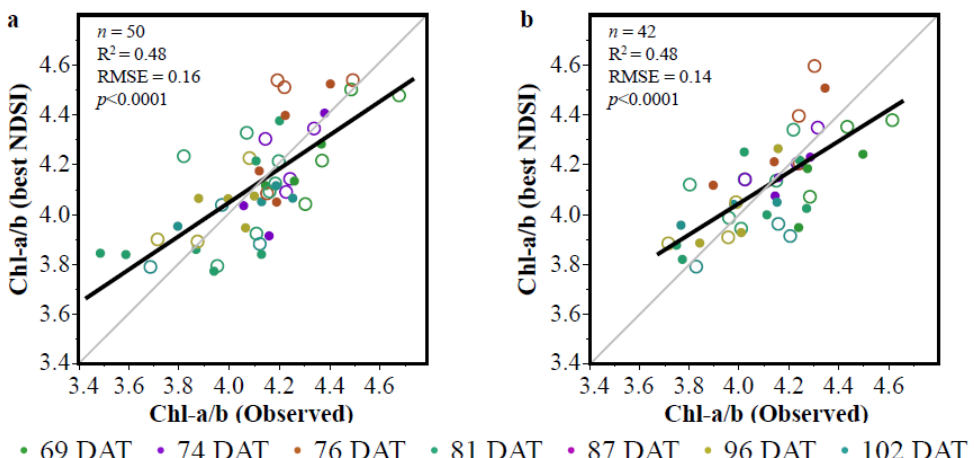
Figure 4. Quality of Chl-a/b spectral estimation by normalized difference spectral index (NDSI). The Chl-a/b (observed) data were acquired by extraction of Chl-a and Chl-b. The Chl-a/b (best NDSI) data were calculated by applying the top (NDSI estimating Chl-a and Chl-b (Table 1). The Val data set is presented in Table 1 ( a ). Averaged values per genotype, irrigation regime and DAT as presented in Figure 3b,d,f ( b ). DAT stands for days after transplant. Hollow and filled dots stand for water-limited (WL) and well-watered (WW), respectively; the black lines are the trend lines and the gray lines are the 1:1 lines.